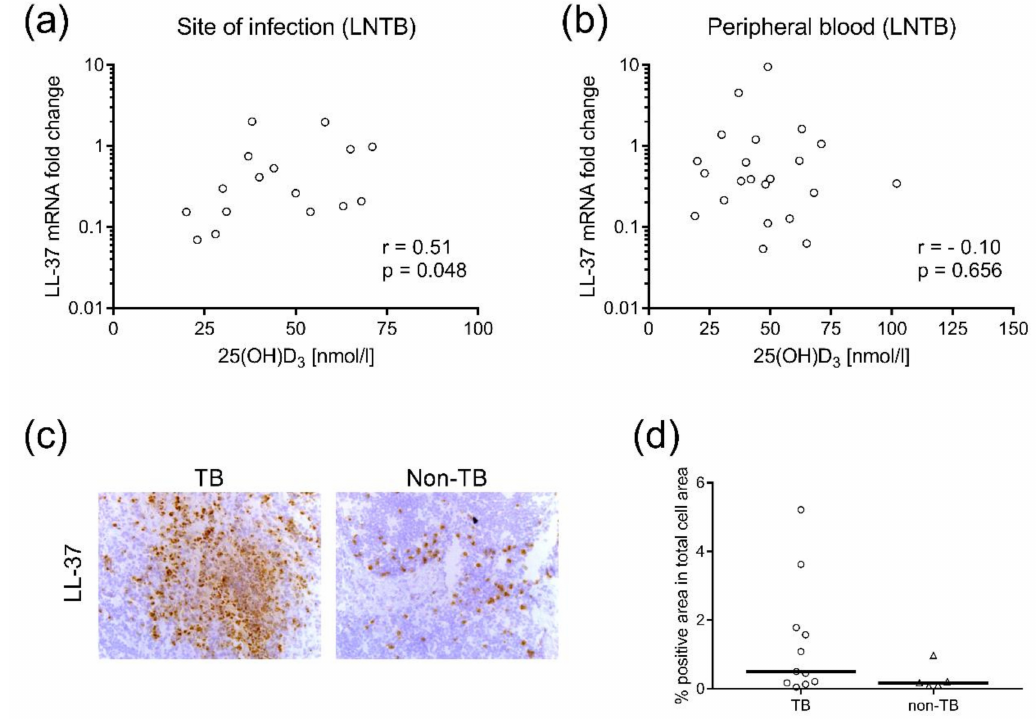
Figure 4. Local expression of LL-37 in patients with lymph node TB (LNTB). Correlation analyses were performed in order to assess the association between plasma concentrations of 25(OH)D 3 and LL37 mRNA expression ( a ) at the local site of infection (lymph node tissue) and ( b ) in the peripheral blood (PBMCs) of patients with LNTB. ( c ) Representative immunohistochemical images show the expression of LL-37 in granulomatous lymph node tissue from a LNTB patient compared to a non-TB control (magnification × 125). Positive cells are depicted in brown, whereas negative cells were counterstained with hematoxylin in blue. ( d ) In situ computerized image analysis was used to determine LL-37 protein expression (median) in LNTB patients ( n = 11) compared to non-TB controls ( n =